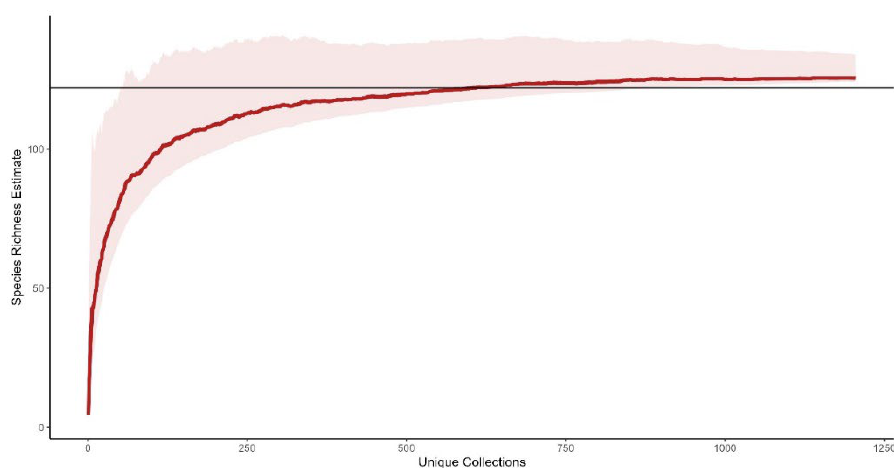
Figure 18. Chao1 species richness estimate for Maryland. Black horizontal line indicates current observed species richness (n = 122). A 95% confidence interval is provided.